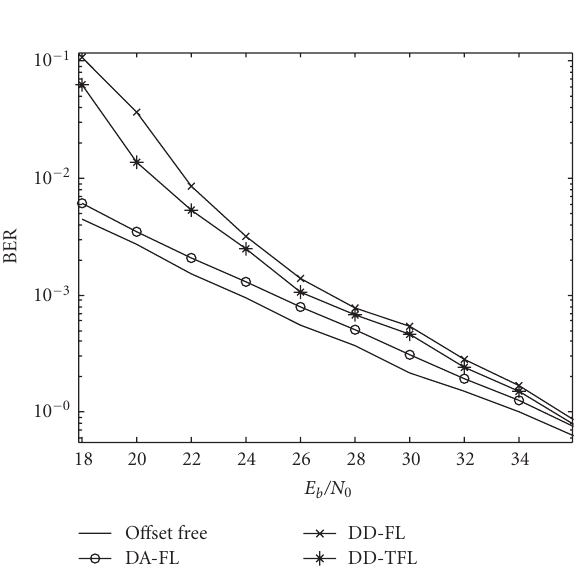
Figure 8: DD-TFL scheme.